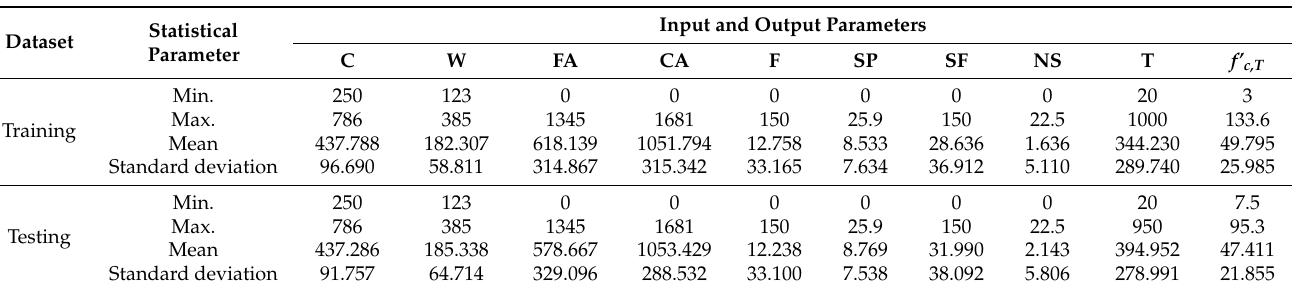
Table 2. Statistics of input and output parameters for the training and testing datasets used in the development of the supervised learning model.